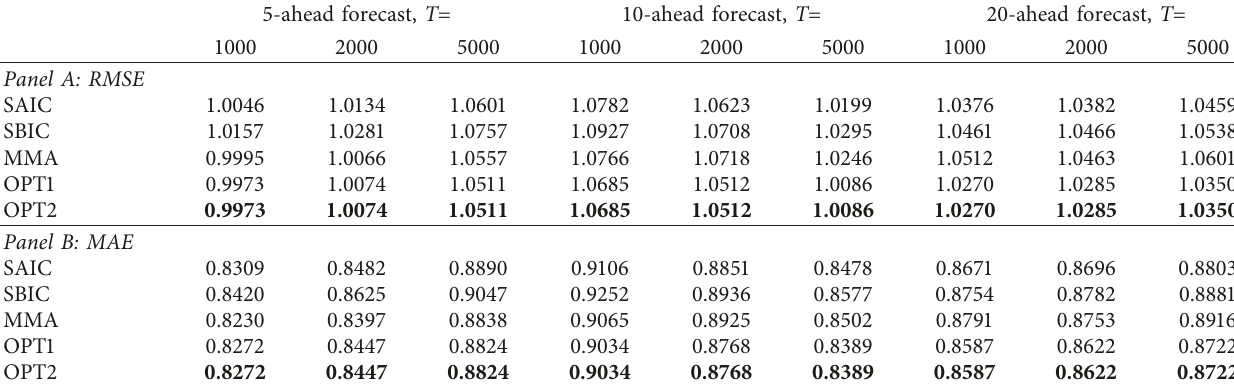
Table 2: Out-of-sample forecasting results for simulation